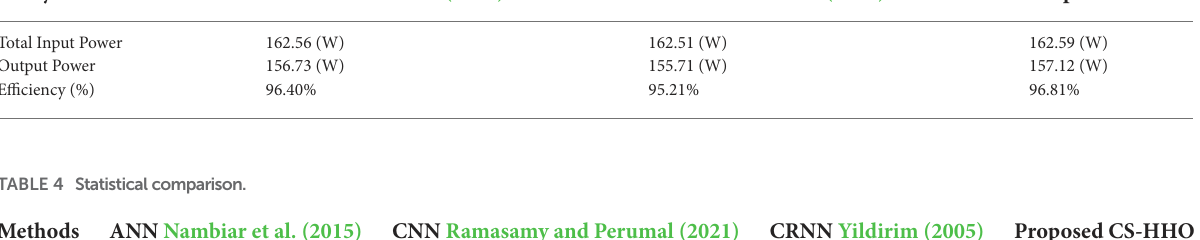
TABLE 3 Efficiencycomparison.